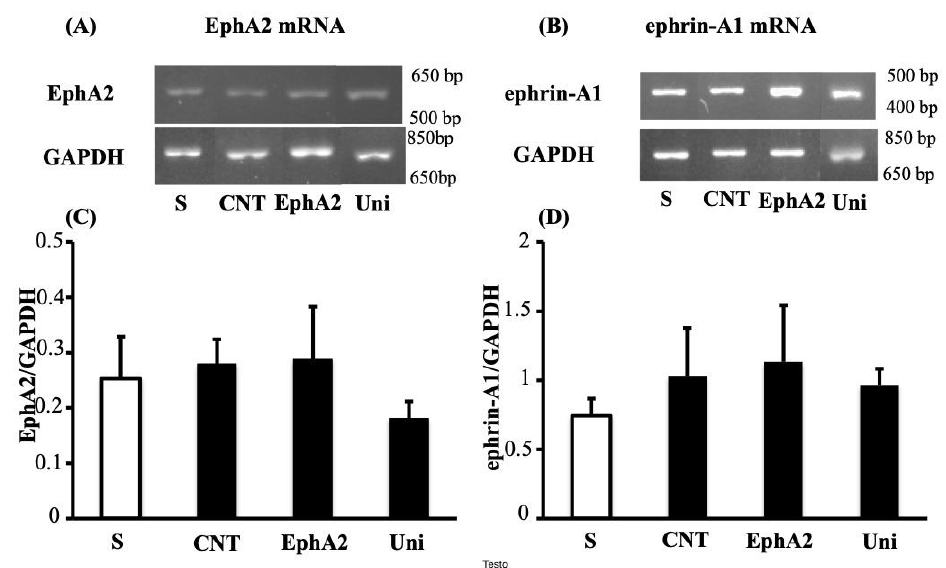
Figure 5. UniPR1331 and EphA2 did not modify colonic levels of EphA2 and ephrin-A1 mRNA . Representative agarose gels showing mRNA levels of EphA2 ( A ), ephrin-A1 ( B ) and GAPDH from the colon of vehicle-treated normal mice (S; n = 5) and of TNBS-treated mice administered with vehicle (CNT; n = 5), EphA2 20 mg/kg (EphA2; n = 5) or UniPR1331 25 mg/kg (Uni; n = 5). Histograms represent the quantification of EphA2 ( C ) and ephrin-A1 ( D ) mRNA levels normalized to GAPDH amplification products. Data are shown as mean ± SEM.